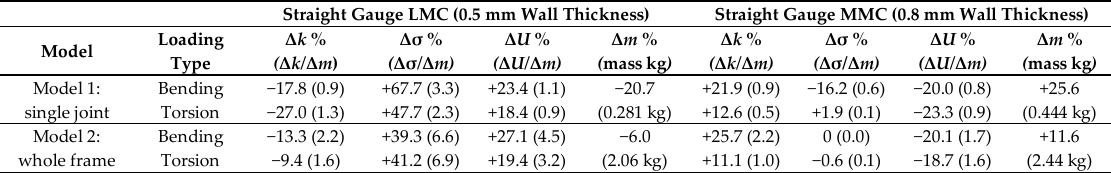
Table 3. Influence of tube butting profiles on stiffness ( k ), stress (σ), strain energy ( U ) and mass ( m ) for Model 1 (single joint: mass of down tube + head tube = 0.354 kg) and Model 2 (whole frame: total mass = 2.19 kg), for in-plane bending and torsion loading conditions. Since the relative changes are of interest here, results are presented as (i) a % change from the 0.8/0.5/0.8 butted tube benchmark model , e.g., Δ k % which is unbracketed; and (ii) the ratio of this change to the % change in mass, e.g., (Δ k /Δ m ) which is bracketed (apart from the mass column where the actual mass is presented in